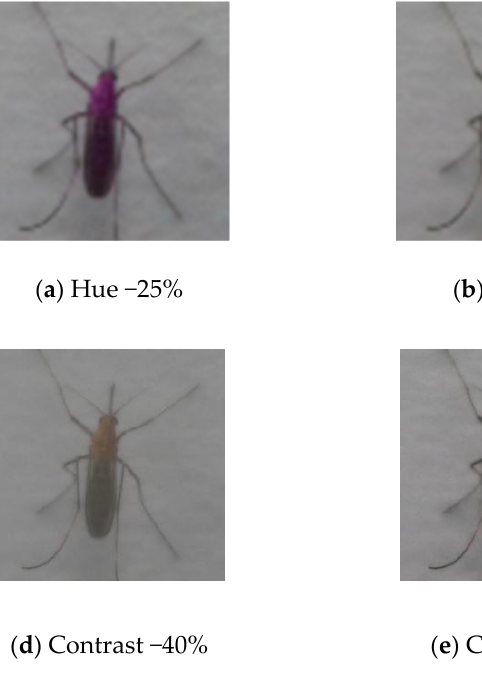
Figure 6. Examples of data argumentation.